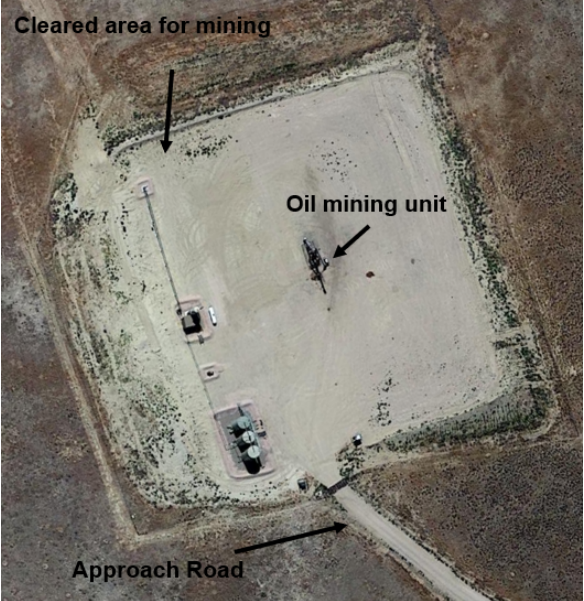
Figure 1. Example of oil pad from google earth.